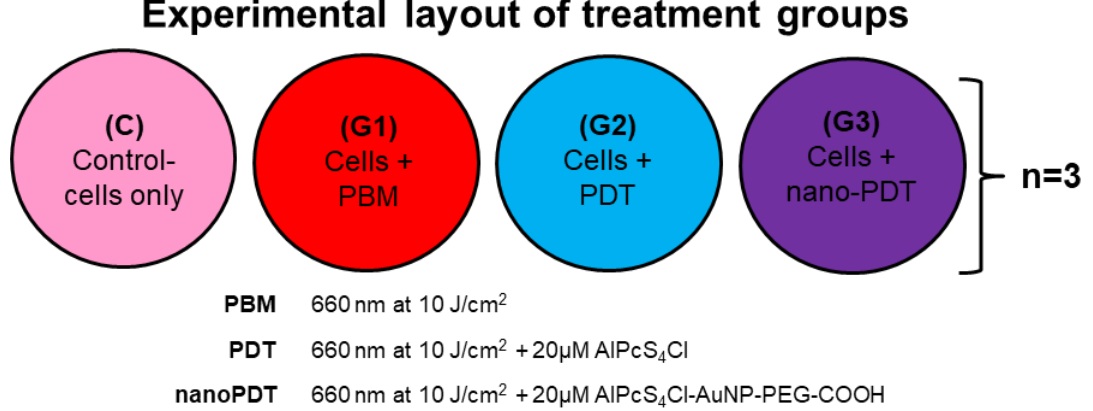
Figure 1. Layout of A549 lung cancer cells and PDT treatment experimental groups.